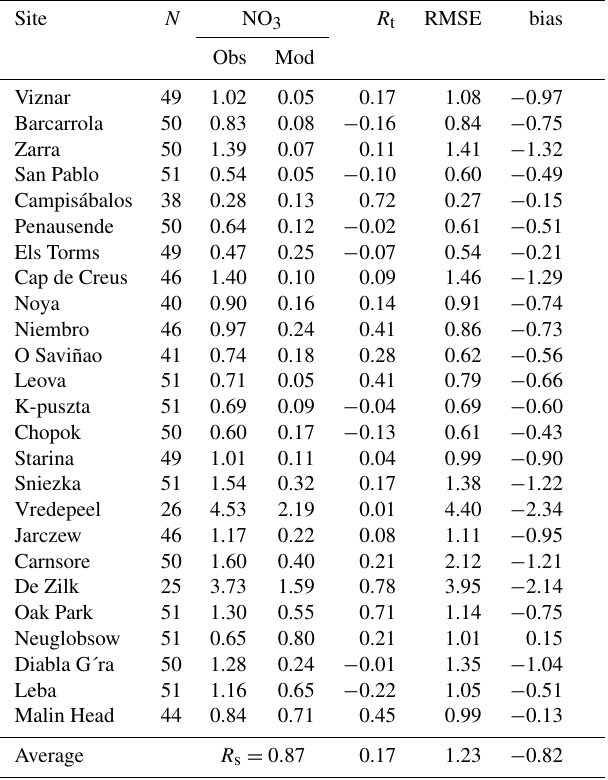
Table 10. Scores for the comparisons between observations (EMEP) and model (CHIMERE) for the nitrate. Results are pre- sented with N the number of daily mean available measurements for the period from 10 June to 30 July 2013, the temporal correla- tion ( R t ), the root mean square error (RMSE) and the bias (model minus observations). The last line “average” represents the spatial correlation R s between the mean observed and modeled values, and the mean averaged values of correlation, RMSE and bias. Stations are sorted in increasing latitude, from south to north.